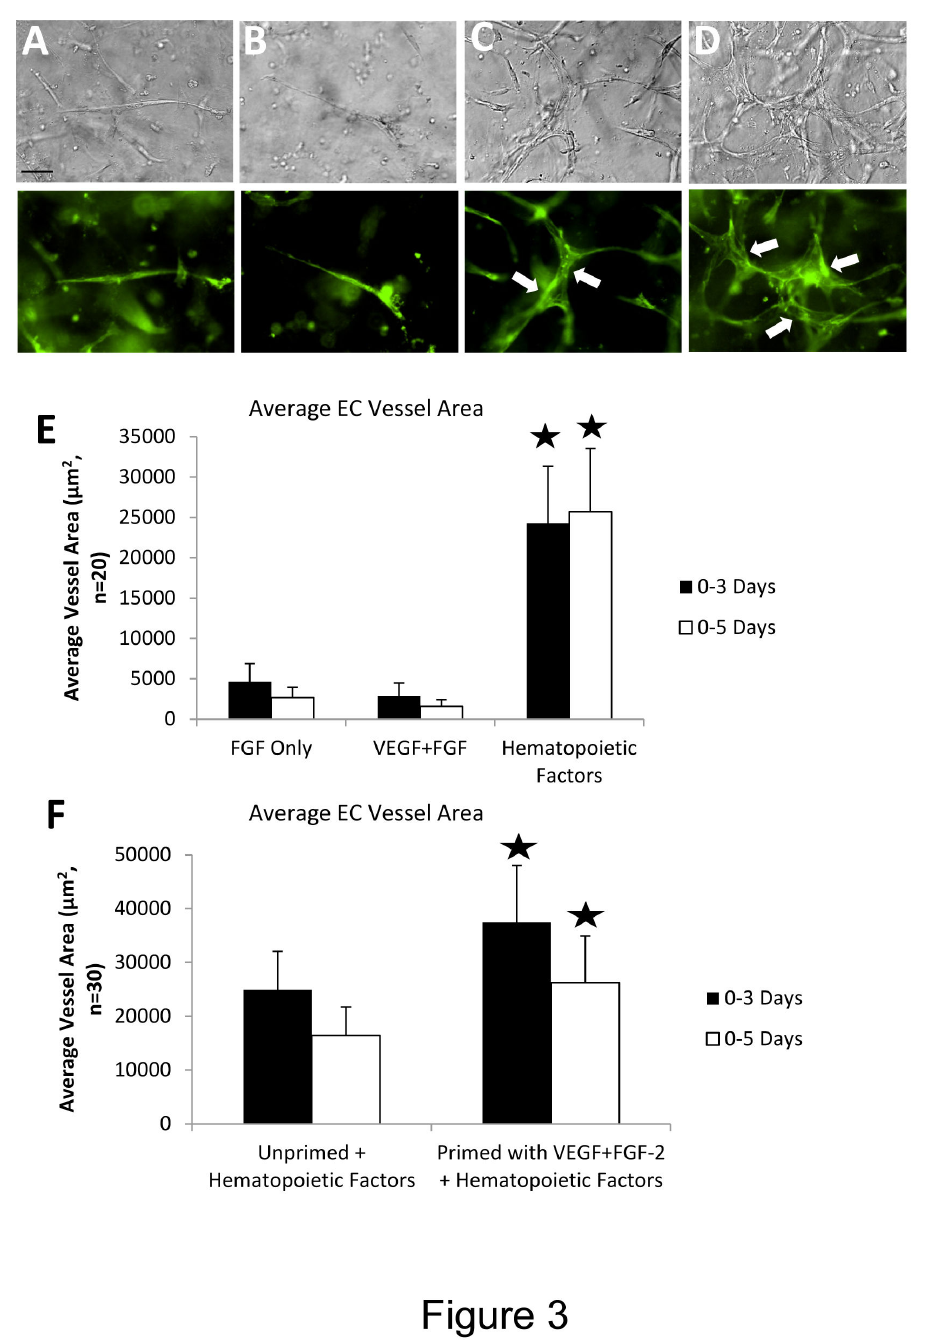
Figure 3. Hematopoietic stem cell cytokines stimulate EC-pericyte tube co-assembly in 3D fibrin matrices. Membrane- targeted GFP labeled ECs were mixed with pericytes in 3D fibrin matrices with various growth factor combinations. The upper panels (A-D) show light microscopic images while the lower panels show fluorescent images of the corresponding light image fields from cultures at 72 hr. (A) FGF-2 only; (B) VEGF+FGF-2; (C) Hematopoietic factors including SCF, IL-3, SDF-1α were added along with FGF-2; (D) Same factors added as C during the assay, but ECs were primed first with VEGF and FGF-2 overnight. Arrows indicate EC-lined tubes. Bar equals 25 µm. (E,F) EC-pericyte co-cultures were established with unprimed (E) or VEGF/FGF-2 primed (F) ECs in 3D fibrin matrices with the indicated growth factors. Cultures were fixed after 72 or 120 hr and tube area was quantitated using Metamorph software. Asterisks indicate significance of p< .01 relative to the FGF only condition (E) (n=20, values are averaged + SD) or relative to the unprimed+hematopoietic factors condition (F) (n=30, values are averaged + SD). doi: 10.1371/journal.pone.0085147.g003 PLOS ONE |